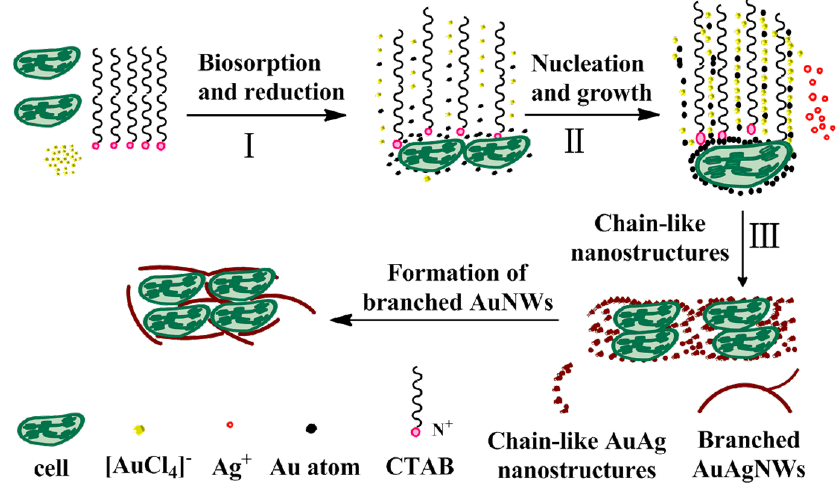
Figure 8. The formation mechanism of Au-Ag nanowires.